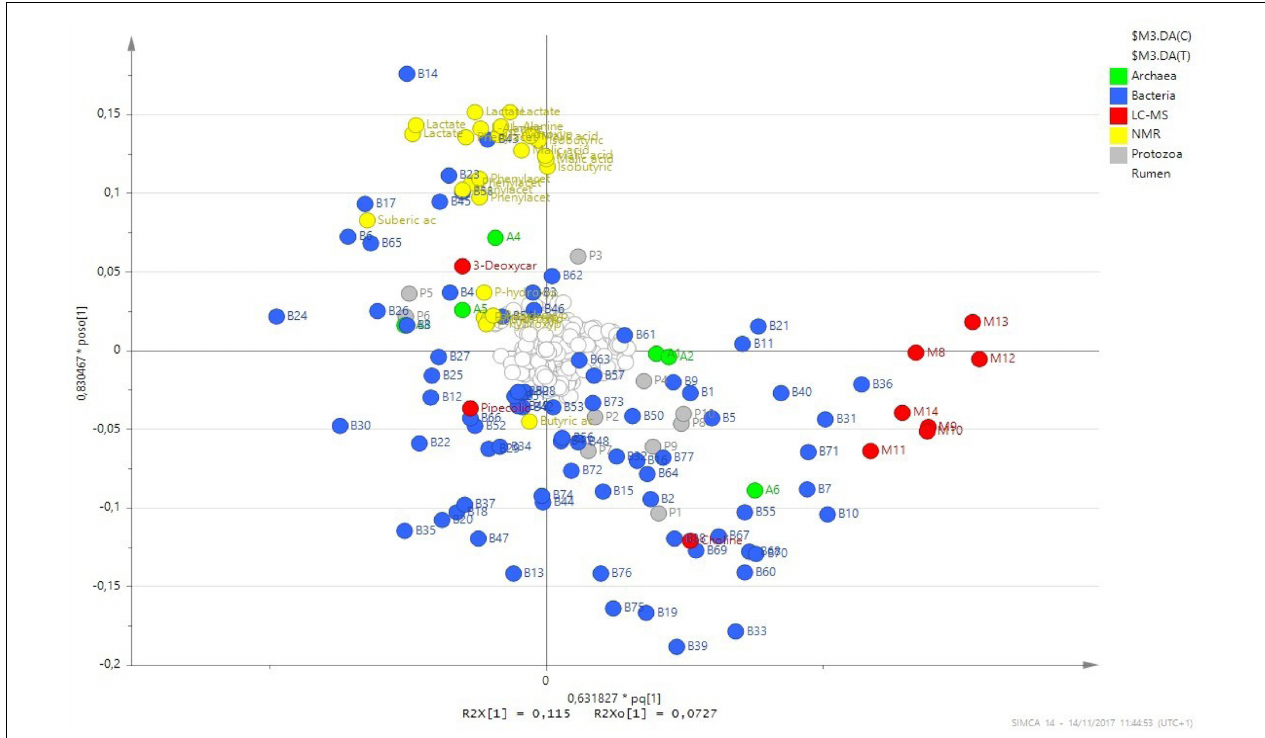
FIGURE 4 | Combined loading plot of the OPLS-DA analysis obtained from rumen fluid samples. Dots represent rumen metabolites detected by NMR (yellow), LC-MS (red-discriminant, white-non-discriminant), archaeal clades (green), bacterial families (blue) and protozoal genera (gray). On the right hand side, metabolites M8 to M14, Bacteroidales B7 and B10, Fibrobacteriaceae B31, Eubacteriaceae B36, an unidentified family from the class Mollicutes B71 and Methanomassiliicoccaceae A6 contributed to the separation between